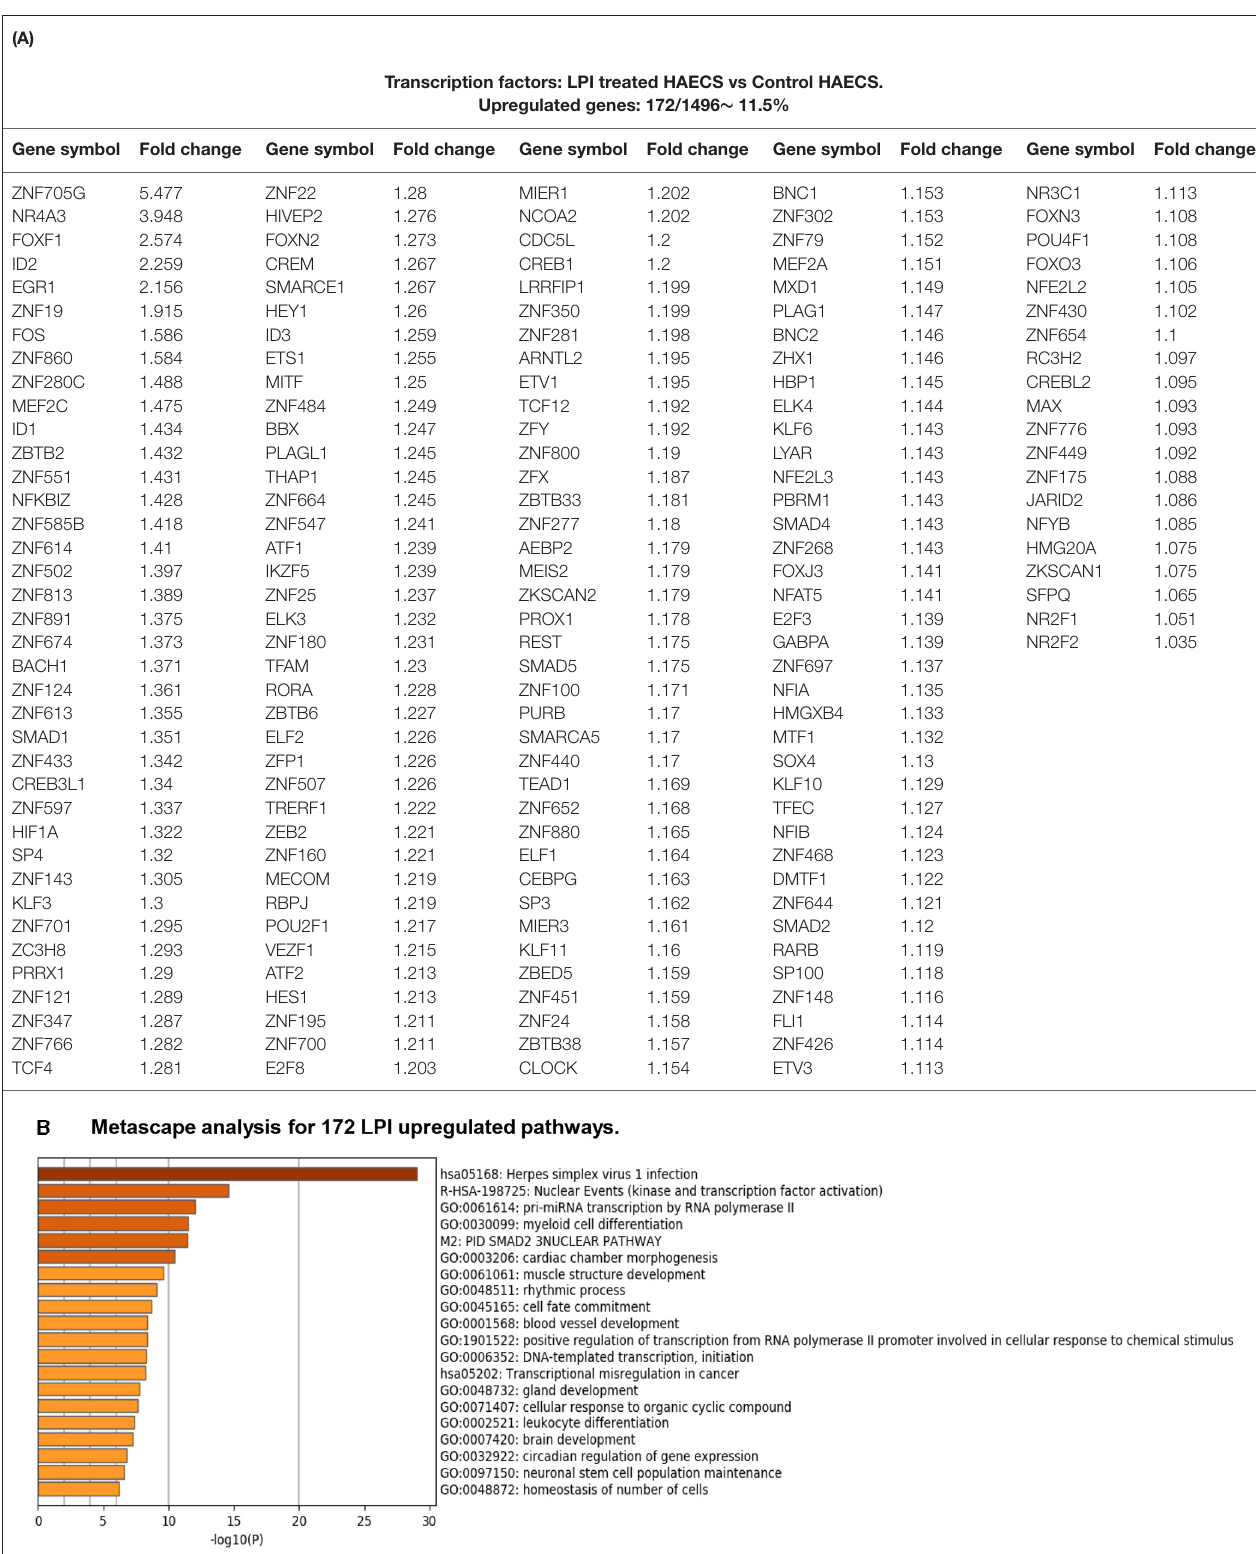
FIGURE 8 | One hundred seventy-two LPI-upregulated transcription factors (TFs) were identified, which mediates 20 pathways after screening for a total of 1,496 TFs. (A) Around 11.5% of the genes (172/1496) showed significant upregulation among total TFs. (B) Metascape pathways and biological process enrichment analysis for upregulated genes in the LPI